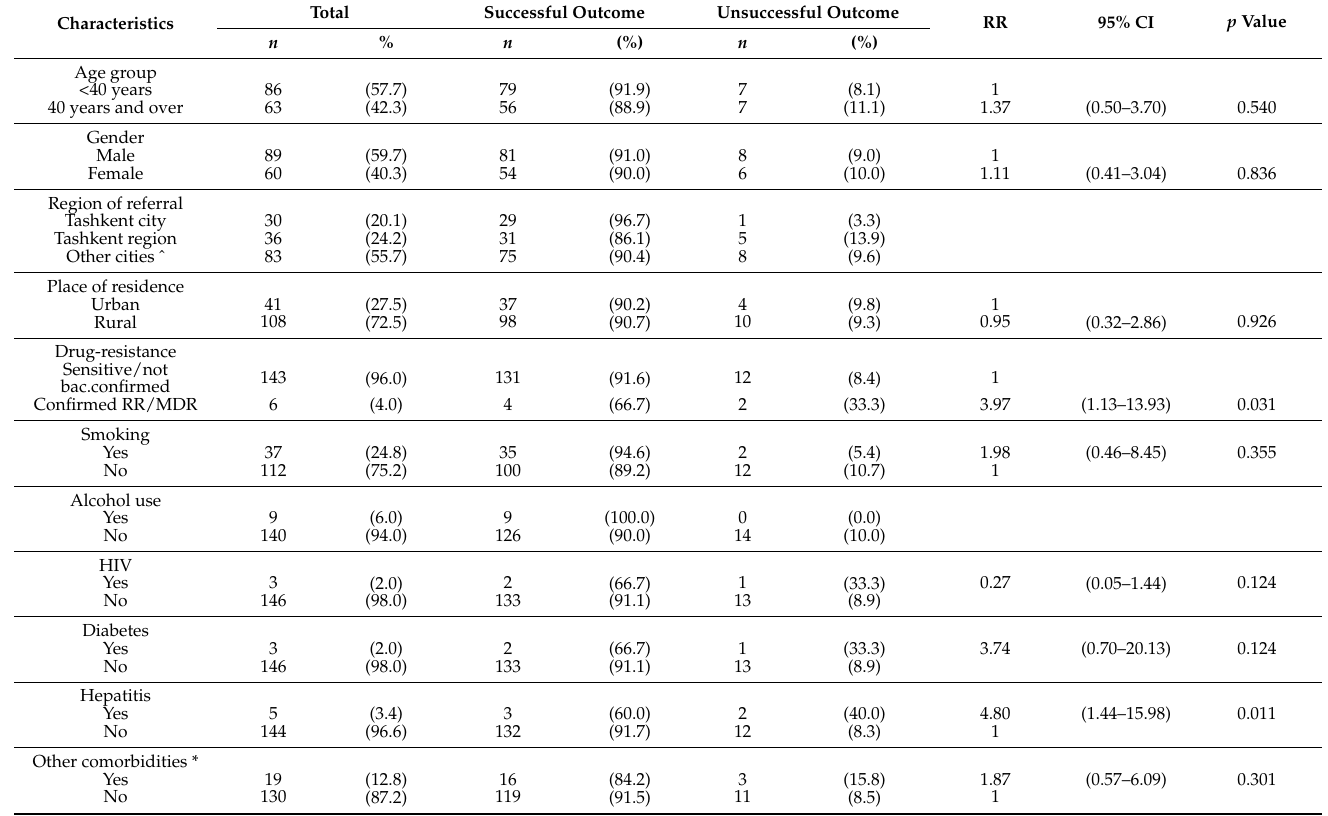
Table 2. Predictors of the treatment outcome in patients with diagnosed tuberculosis pleural effusion enrolled into treatment in RSSPMCPP, Tashkent, Uzbekistan,